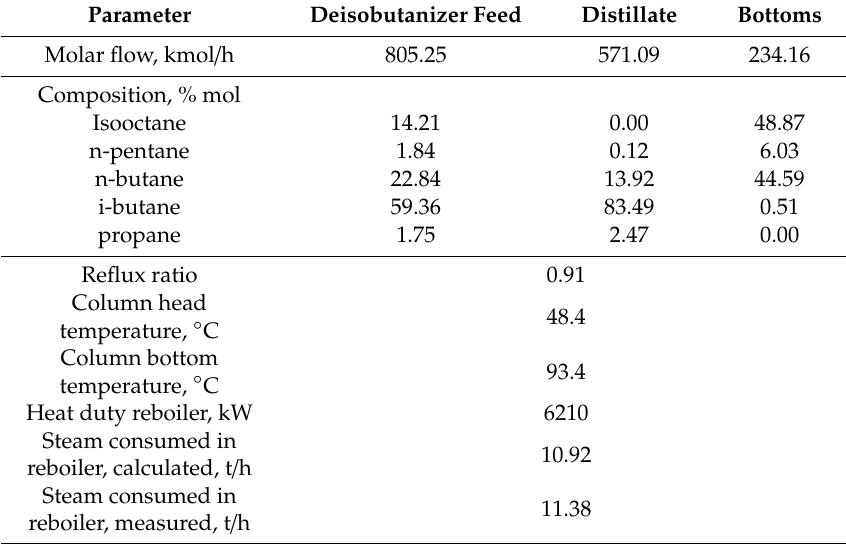
Table 8. Calculated operation data for deisobutanizer column; 26 February 2018: daily average, corresponding to alkylate production of 13.5 t / h.